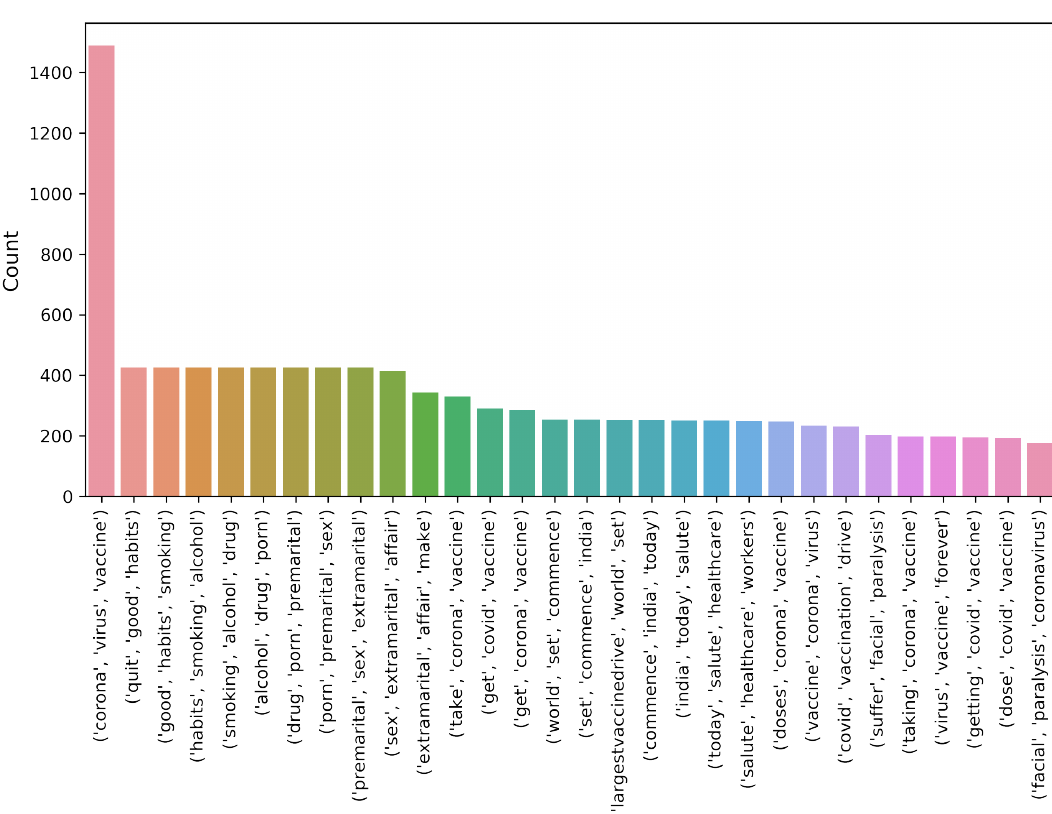
Figure 7. Chart for tri-gram terms from the collected